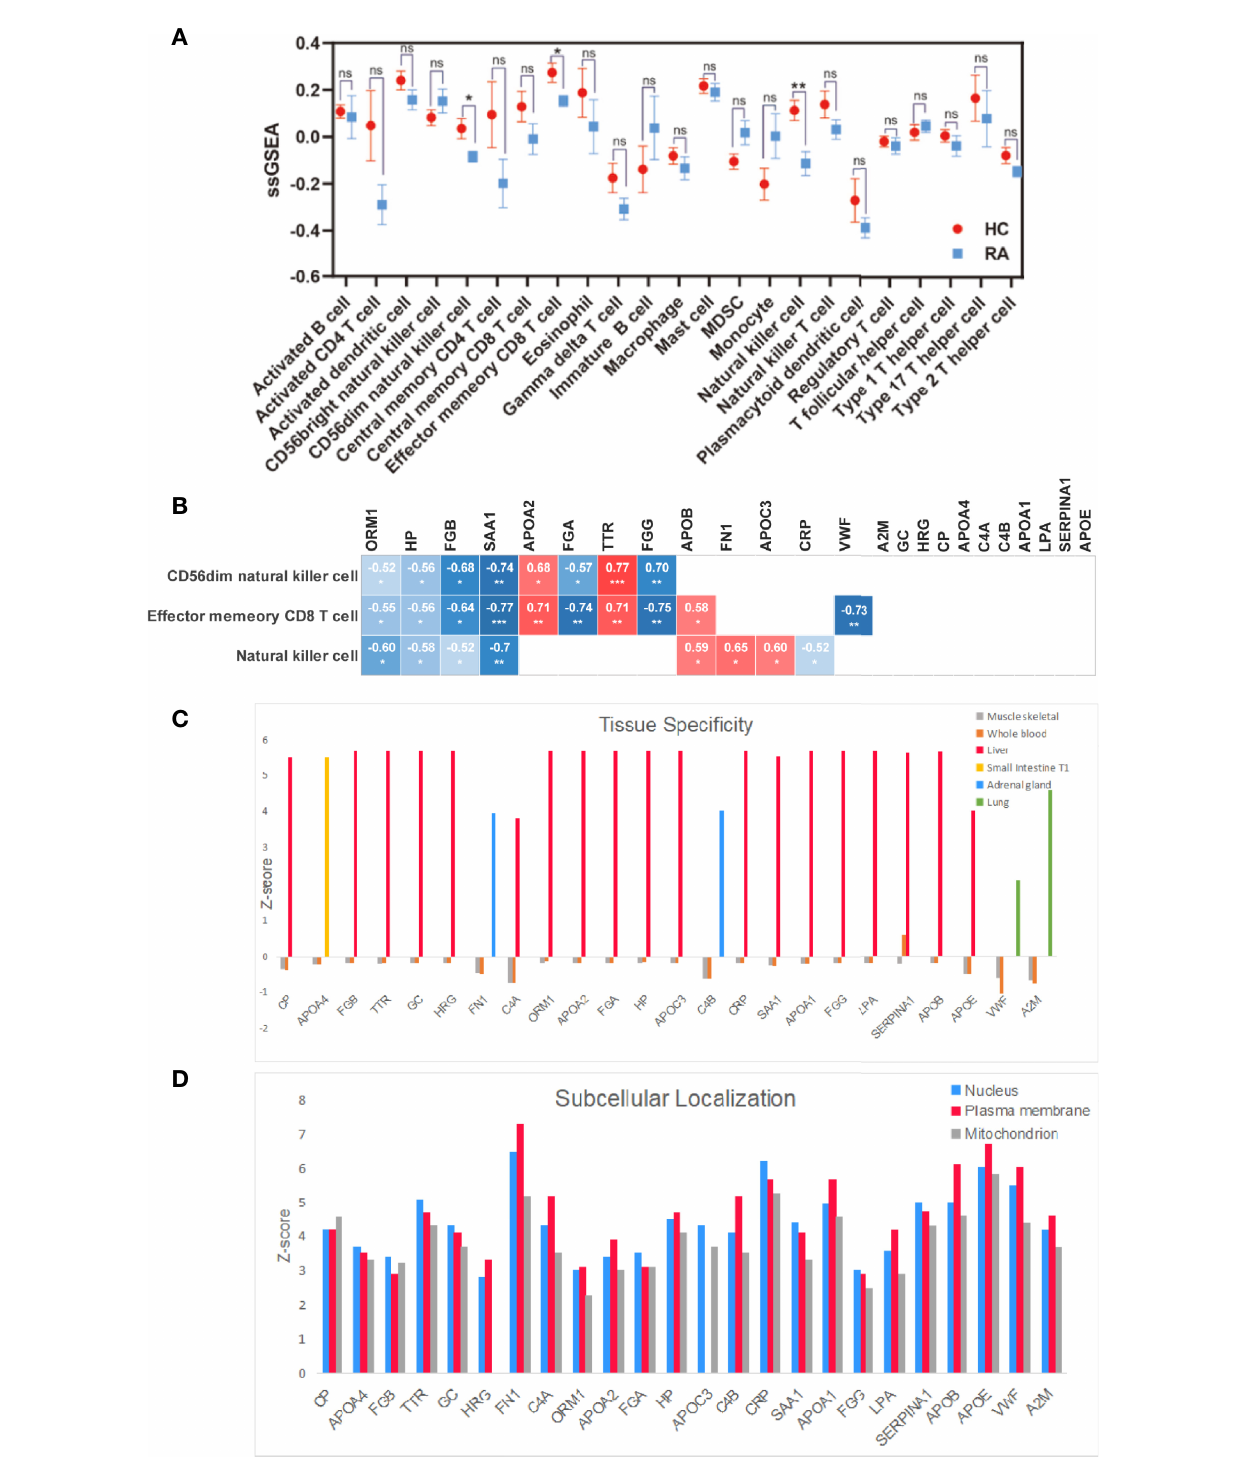
FIGURE 4 | Multi-angle analysis of 24 differentially expressed proteins. (A) Immune in fi ltration analysis protein expression in 23 immune cells in healthy controls and RA patient. (B) Correlation analysis of 24 proteins with statistically signi fi cant immune cells. (C) Tissue speci fi city of 24 differential proteins. (D) Subcellular localization of 24 differential proteins. * p < 0.05, ** p < 0.01, *** p < 0.001. ns, no signi fi